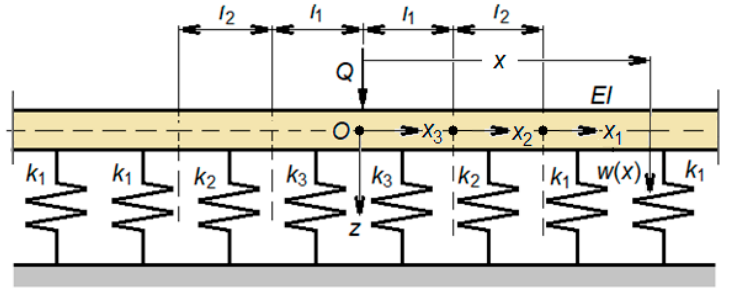
Figure 10. Explanation of the equilibrium position.